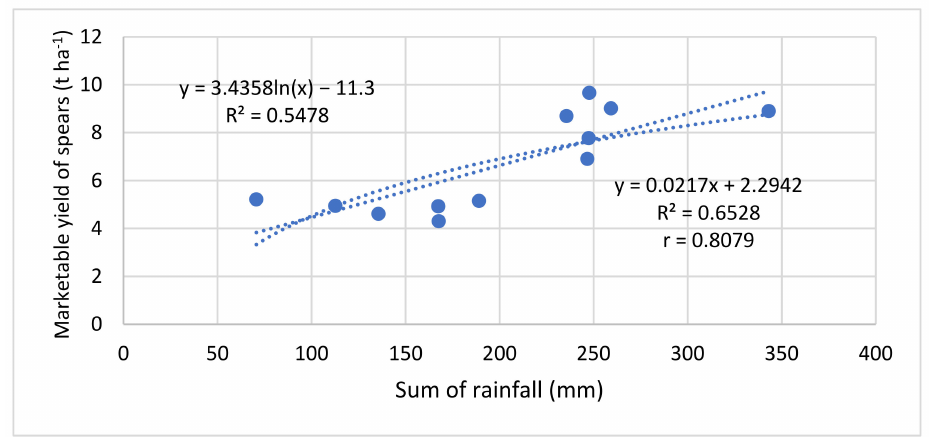
Figure 2. Relationships between the sum of rainfall and irrigation rates in July–August and mar- ketable yield of green spears of